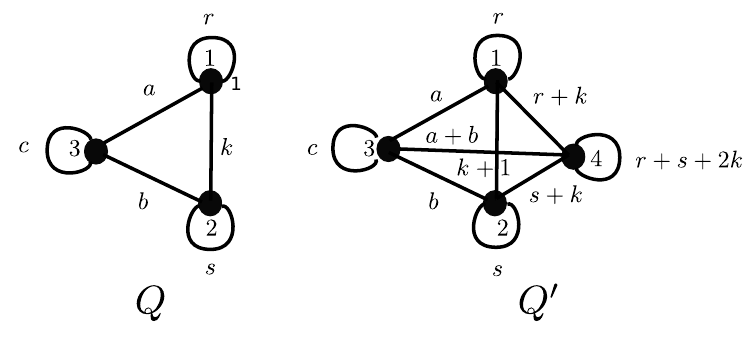
Figure 8. Linking | general